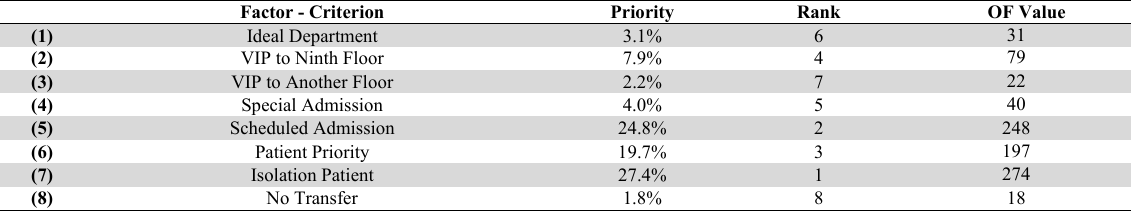
Weights based on the pairwise comparison